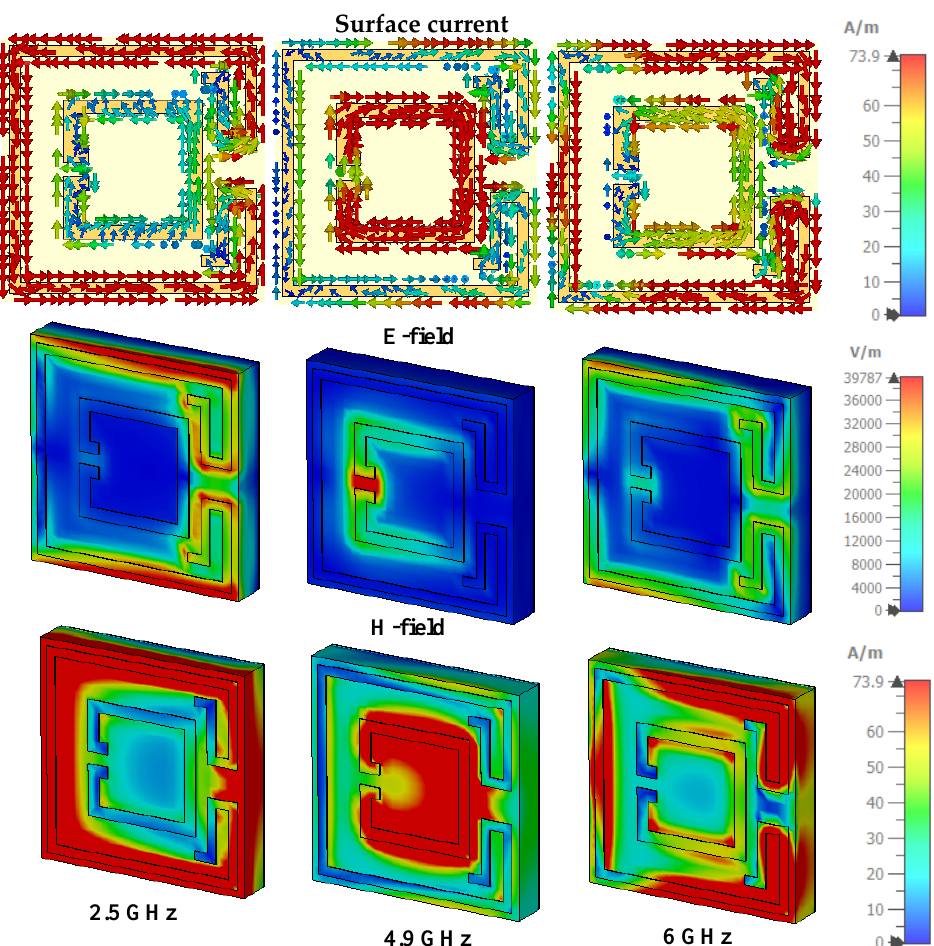
Figure 9. E-field, H-field Abs (absolute value) component, and surface current distribution (TE). The relation between current allocation, magnetic field and electric field in time- varying EM waves can be analyzed from Maxwell Equations (14) and (15) [52,53], where Equation (14) is Faraday’s law of EM induction. Equation (15) represents the modified form of Ampere’s law ∂ D / ∂ t (displacement